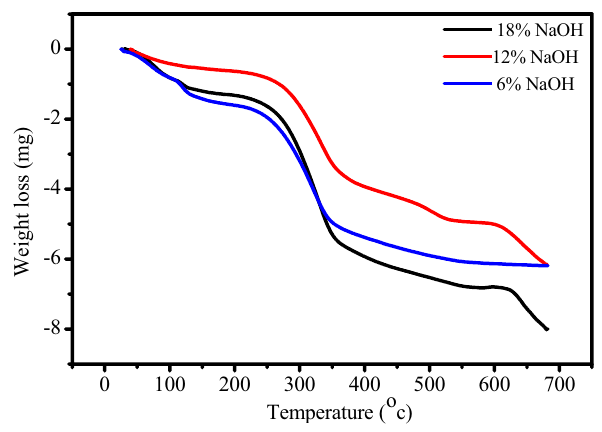
Fig. 4 TGA analysis of alkali-treated Y.alpina bamboo fiber with var- ious NaOH concentrations